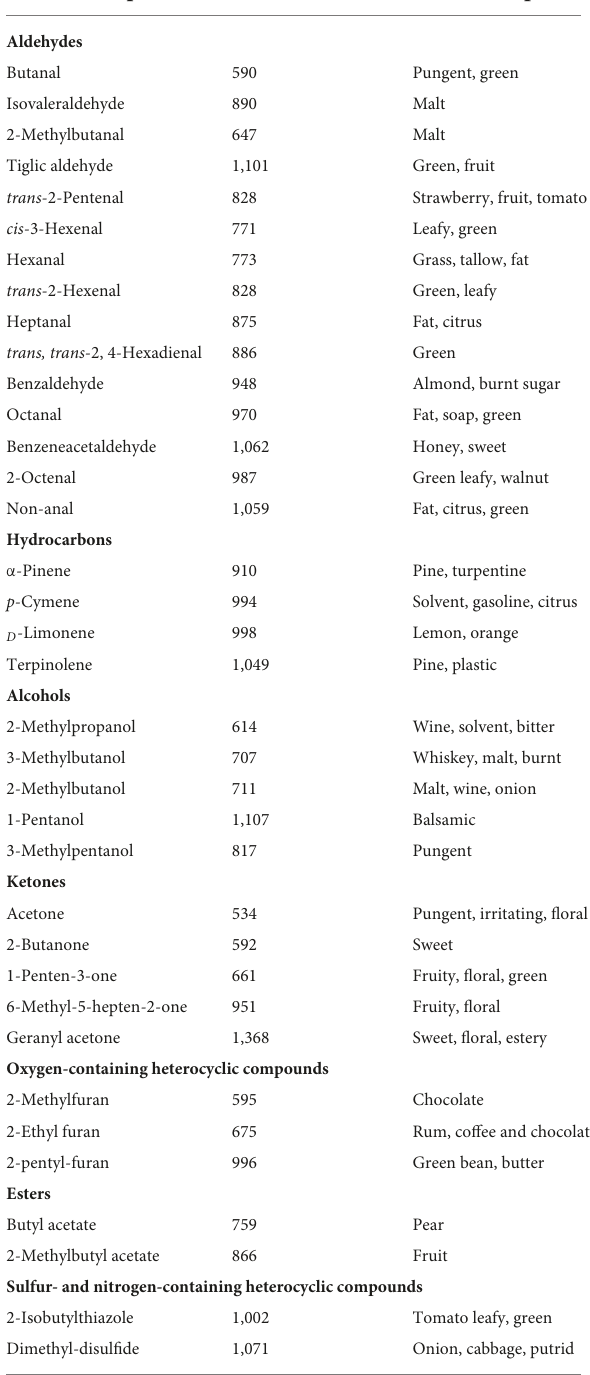
TABLE 1 The retention index and odor descriptions of the volatile compounds identified by the GC-MS